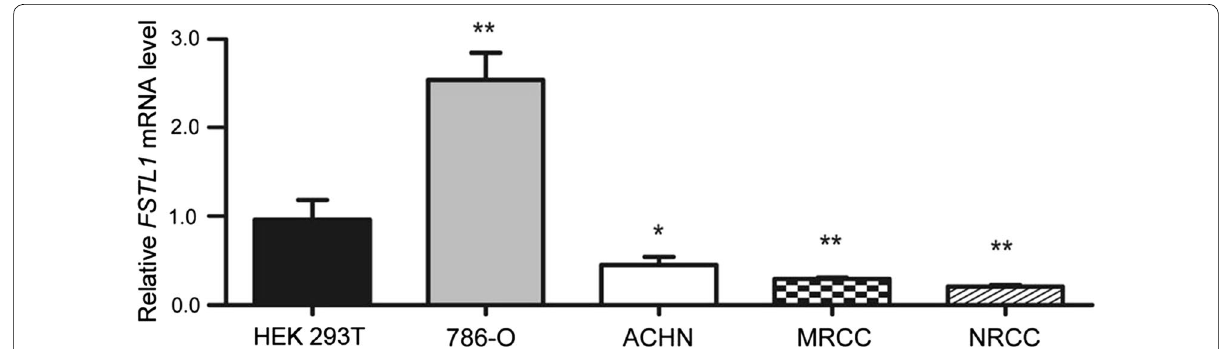
Fig. 1 Follistatin-like protein 1 ( FSTL1 ) mRNA expression levels in clear cell renal-cell carcinoma (ccRCC) and kidney cell lines. Relative levels of FSTL1 mRNA expression in ccRCC cell lines (ACHN, NRCC, MRCC, and 786-O) and human embryonic kidney (HEK) 293T cells (* P < 0.05, ** P <